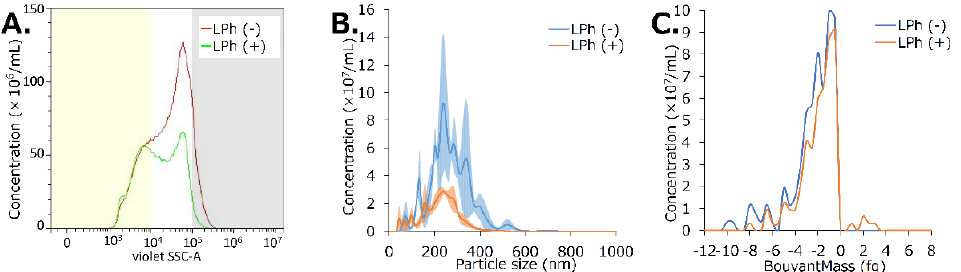
Figure 5. Characteristic changes of bubbles in solution before and after lyophilization. ( A ) Compar- ison of bubble concentration and size distribution using flow cytometry (FCM) analysis. ( B ) Com- parison of bubble concentration and particle size using nanoparticle tracking analysis (NTA). ( C ) Comparison of bubble concentration and buoyant mass using Resonance Mass Measurement (RMM) analysis. LPh (−): solution before lyophilization; LPh (+): solution after lyophilization.